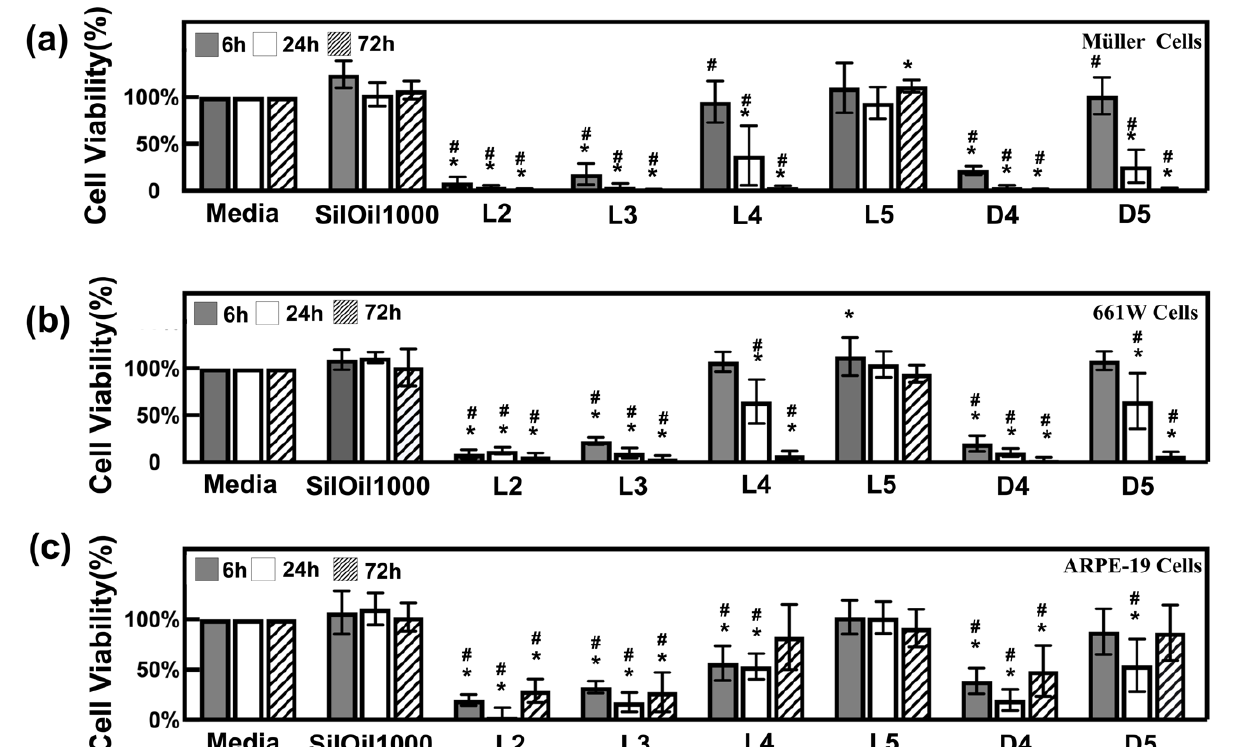
Figure 2. Cytotoxicity of liquid LMWCs. Cell viability of ( a ) Müller cells (rMC-1); ( b ) photoreceptor cells (661W); and ( c ) retinal pigment epithelial cells (ARPE-19) after incubation with various types of LMWCs at different time points. n = 6, * p < 0.05, vs. media; # p < 0.05, vs. SilOil 1000 (one-way ANOVA followed by Bonferroni test). Scale bar = 50 µ m. The results in ( a – c ) are representative of those from 3 independent experiments with 2 replicates each.